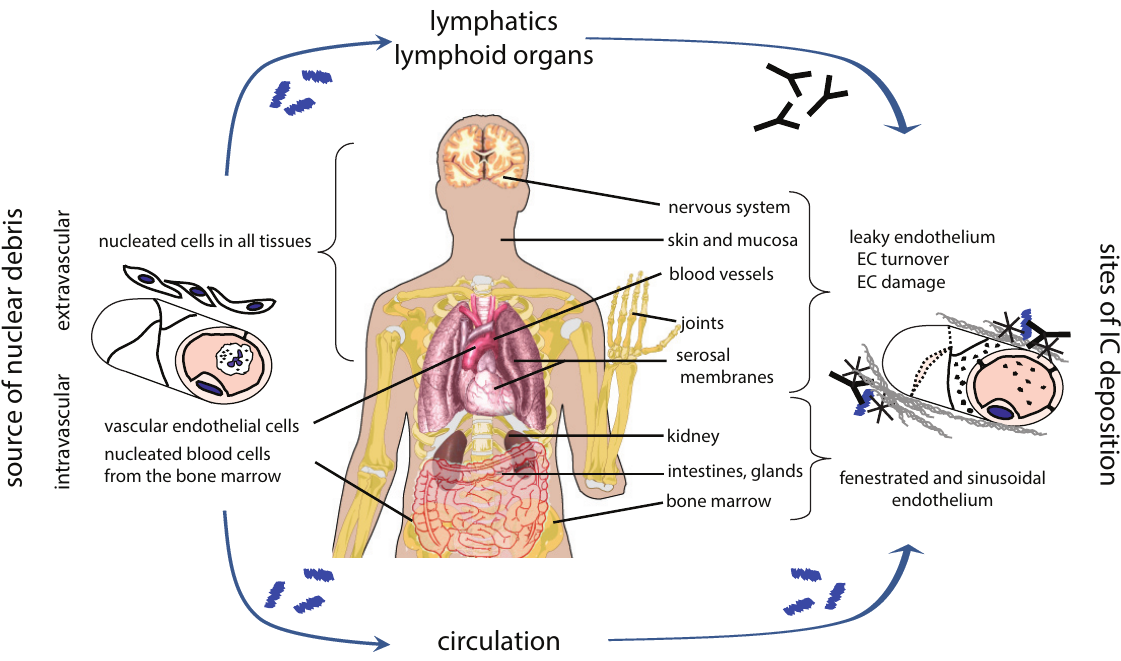
Figure 4. Endothelial deprotection and organ involvement in SLE. Apoptotic nuclear material can originate within the circulation or outside of the circulation. Apoptotic or apoptosis-prone nucleated blood cells can enter the blood stream from the bone marrow crossing the sinusoid endothelium. Endothelial cell apoptosis can be triggered by physical or pharmacological stimuli. These events result in circulating apoptotic debris load unless it is swiftly removed by physiological clearance pathways. Apoptotic debris outside of the circulation reaches the draining lymph nodes. Anti-nuclear antibody production is induced in the lymphoid organs when genetic and environmental susceptibility factors interact. Nuclear debris within the circulation is covered by various clearance molecules, including C1q. Anti-nuclear IgM and IgG